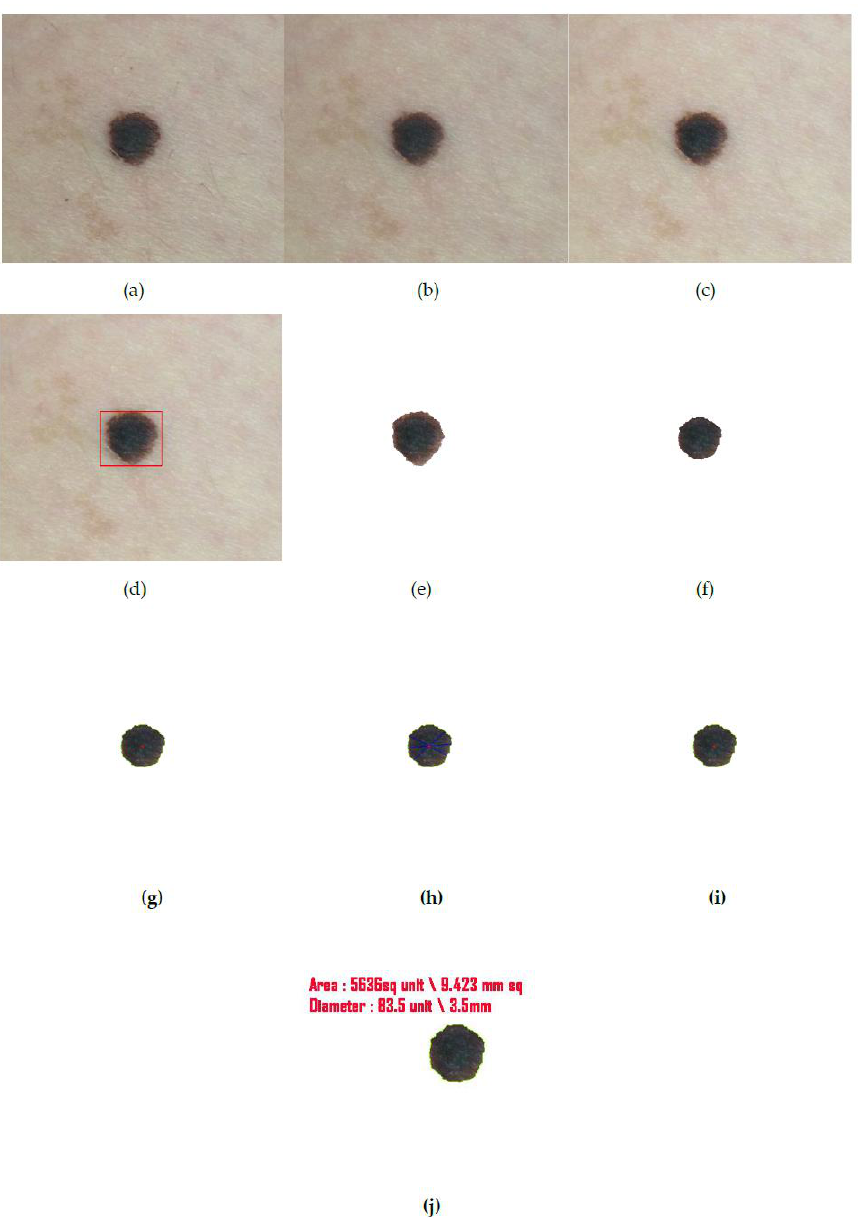
Figure 15. ( a ) Input captured image from camera, ( b ) output image after hair removal, ( c ) enhanced image, ( d ) location detection by YOLOv3, ( e ) segmented image after iteration I, ( f ) segmented image after iteration II (final segmented output), ( g ) center point detection of the final segmented output, ( h ) asymmetry and border irregularity detection by calculating d ki and d kj , ( i ) the color variation detection and segregation on lesion images. ( j ) Here the focal length of the camera f and the distance of the object from the camera u is automatically calculated whose values are 3.5 mm and 80 mm, respectively and thereby the diameter and area are also expressed in terms of millimeters.